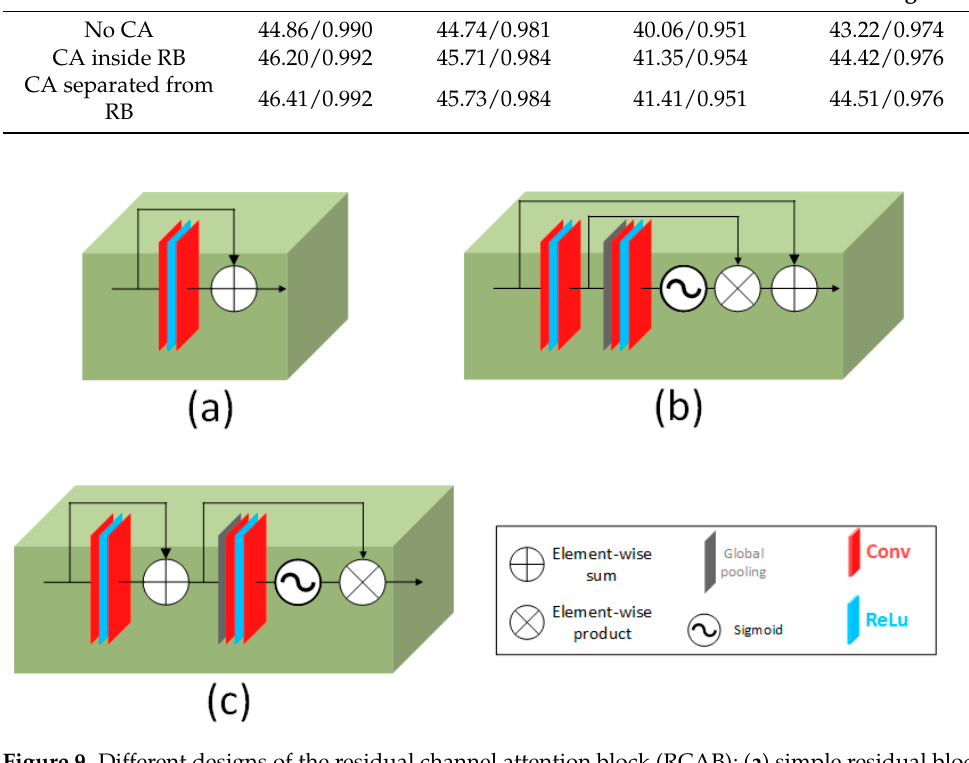
Figure 9. Different designs of the residual channel attention block (RCAB); ( a ) simple residual block (RB) without the channel attention mechanism; ( b ) the proposed RCAB with the CA integrated inside [39] ; ( c ) the proposed RCAB with a CA separated from the RB.